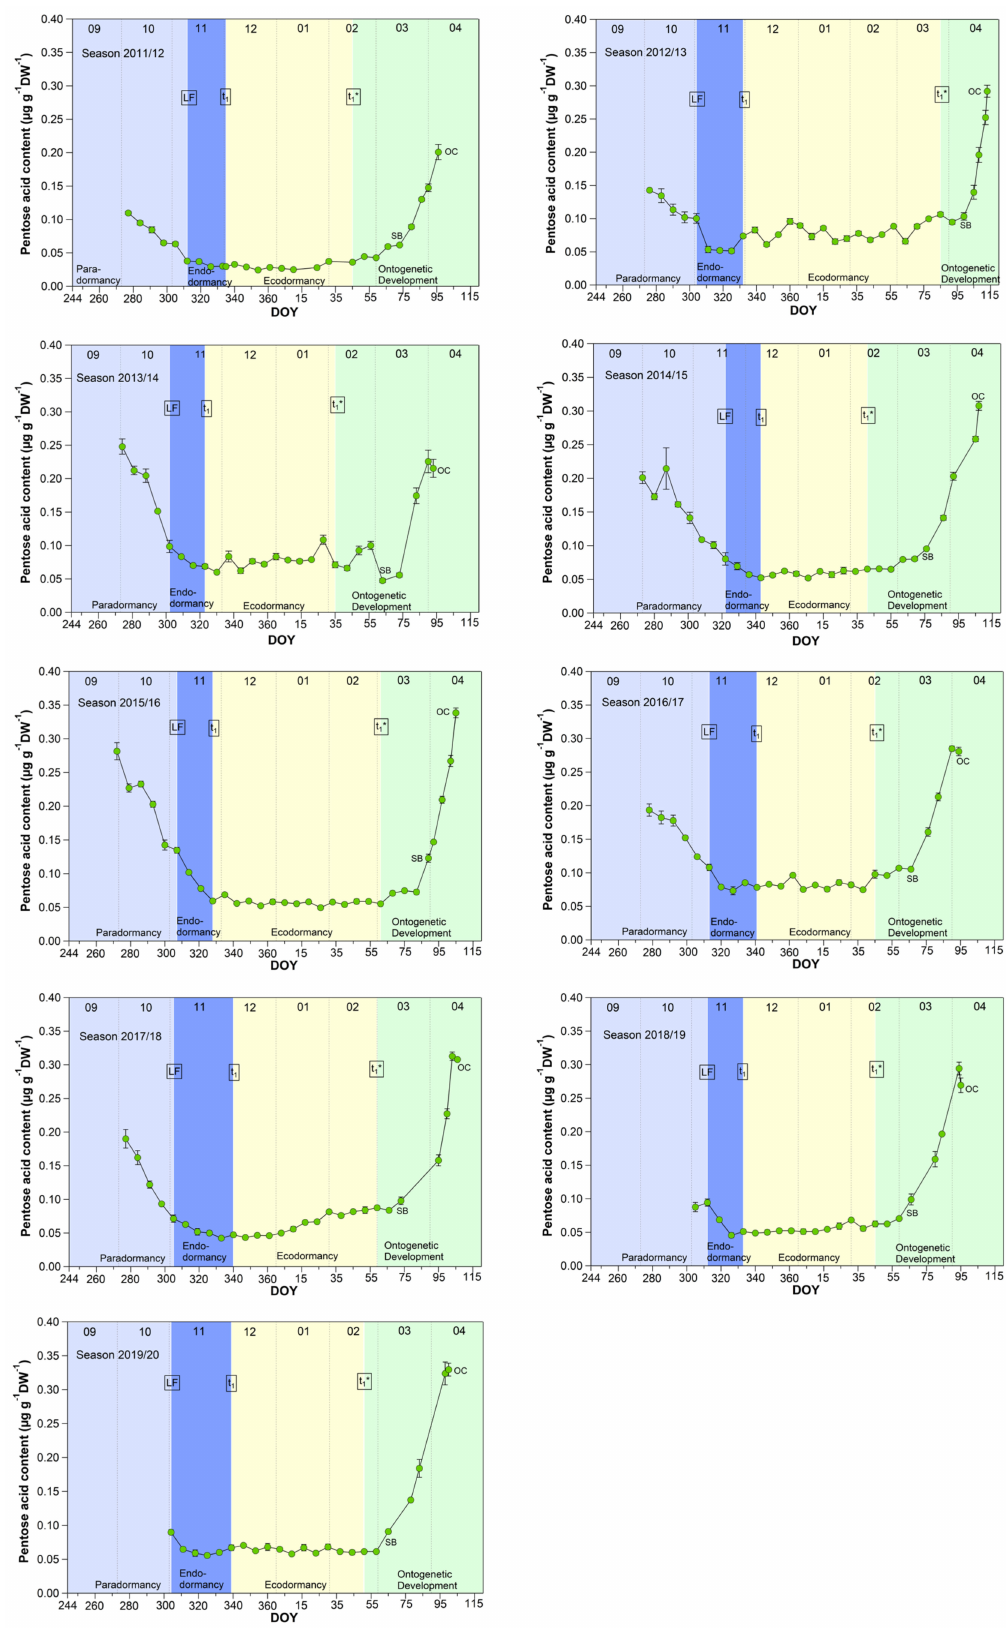
Figure 3. Pentose acid in sweet cherry buds cv. Summit, 2011/12–2019/20. ‘Total leaf fall’ (LF), endodormancy release (t 1 ), beginning of ontogenetic development (t 1 *), ‘swollen bud’ (SB) and ‘open cluster’